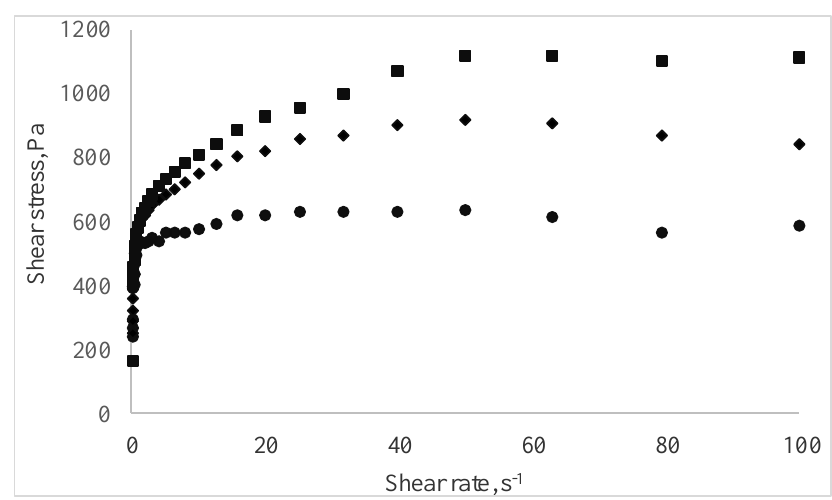
Figure 3. Curves of the pastry cream samples supplemented with different amounts of MBC (Control—full circles, 5% MBC—full diamonds, 10% MBC—full square).